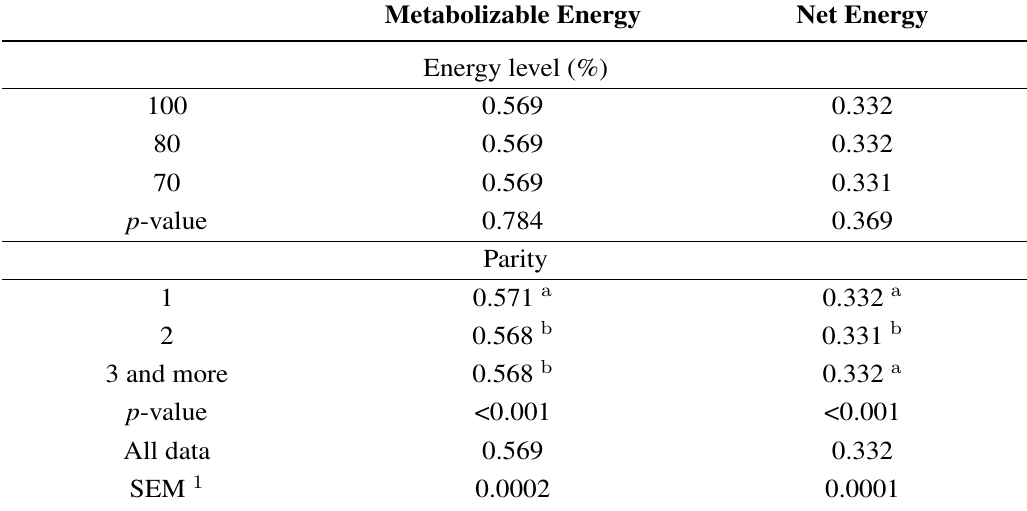
Table 3. Effect of energy level and parity on energy requirement for maintenance (MJ/kg BW 0 . 75 ).